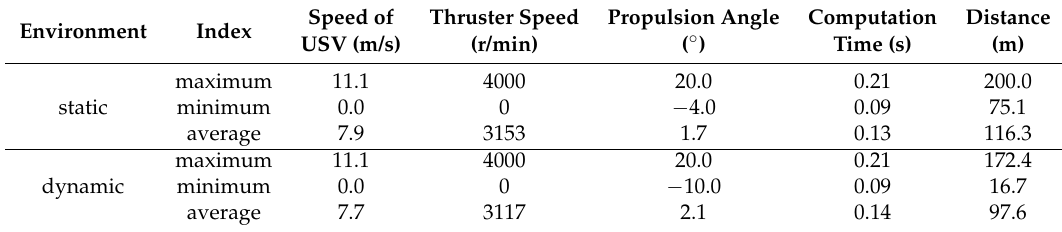
Table 5. Results of the evaluation index comprised of two tests in a real